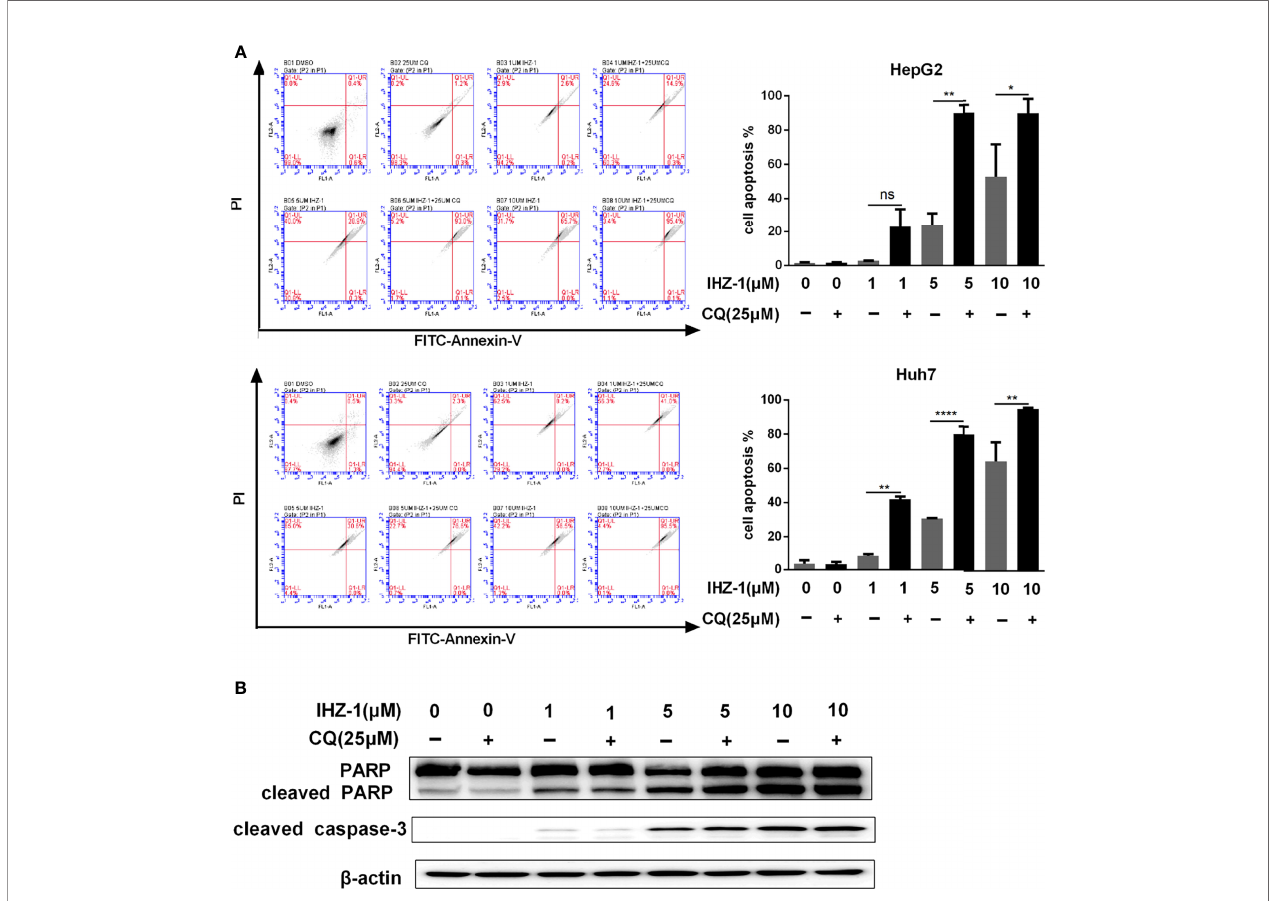
FIGURE 4 | Suppression the autophagy fl ux enhanced by IHZ-1 promote apoptosis. (A) The autophagic fl ux induced by IHZ-1 was inhibited by CQ. The apoptotic cells were then evaluated by fl ow cytometry with Annexin-V/PI staining. (B) The apoptosis-related protein levels were determined by Western blotting. *p < 0.05,